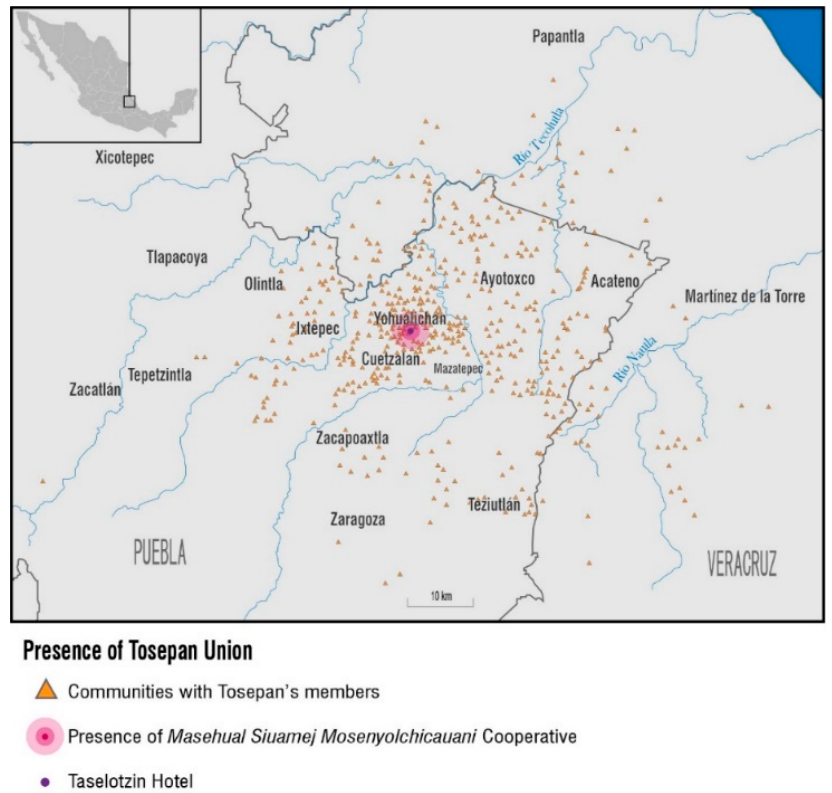
Figure 1. Presence of Tosepan’s collectives and Masehual Siuamej in Puebla and Veracruz states. Source: adapted from Habitat International Coalition – Latin America HIC-AL (2018).